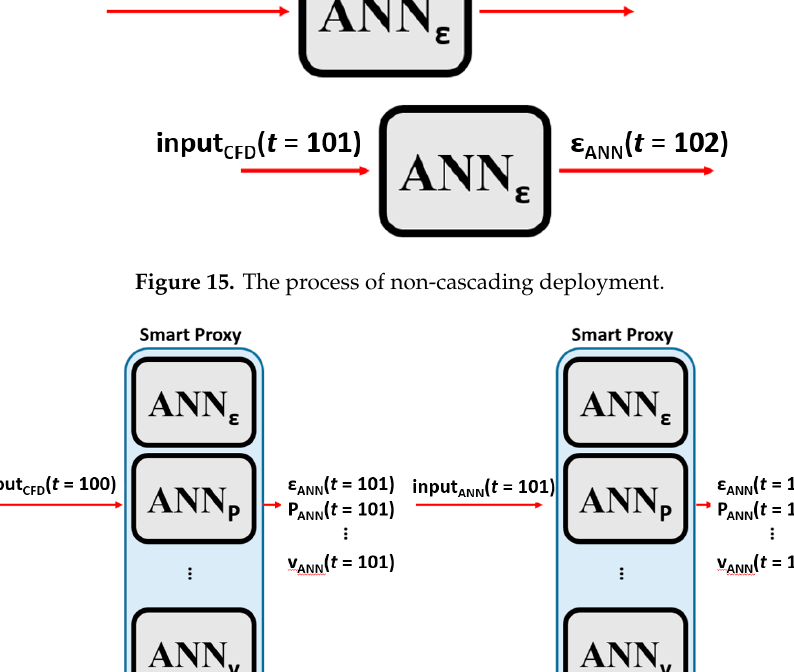
Figure 15. The process of non-cascading deployment. Figure 16. The process of cascading Figure 16. The process of cascading deployment.